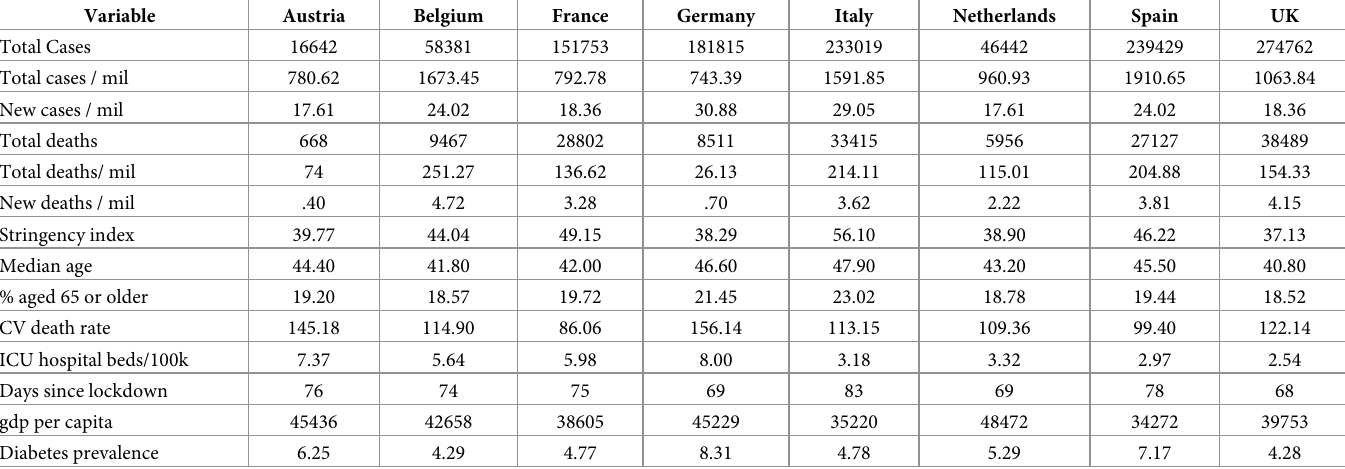
Table 1. Descriptive statistics for each country through to June 1,